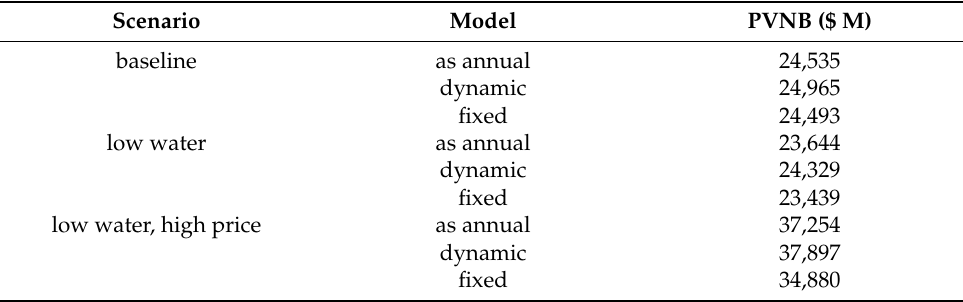
Table 6. Present Value Net Benefit by scenario and